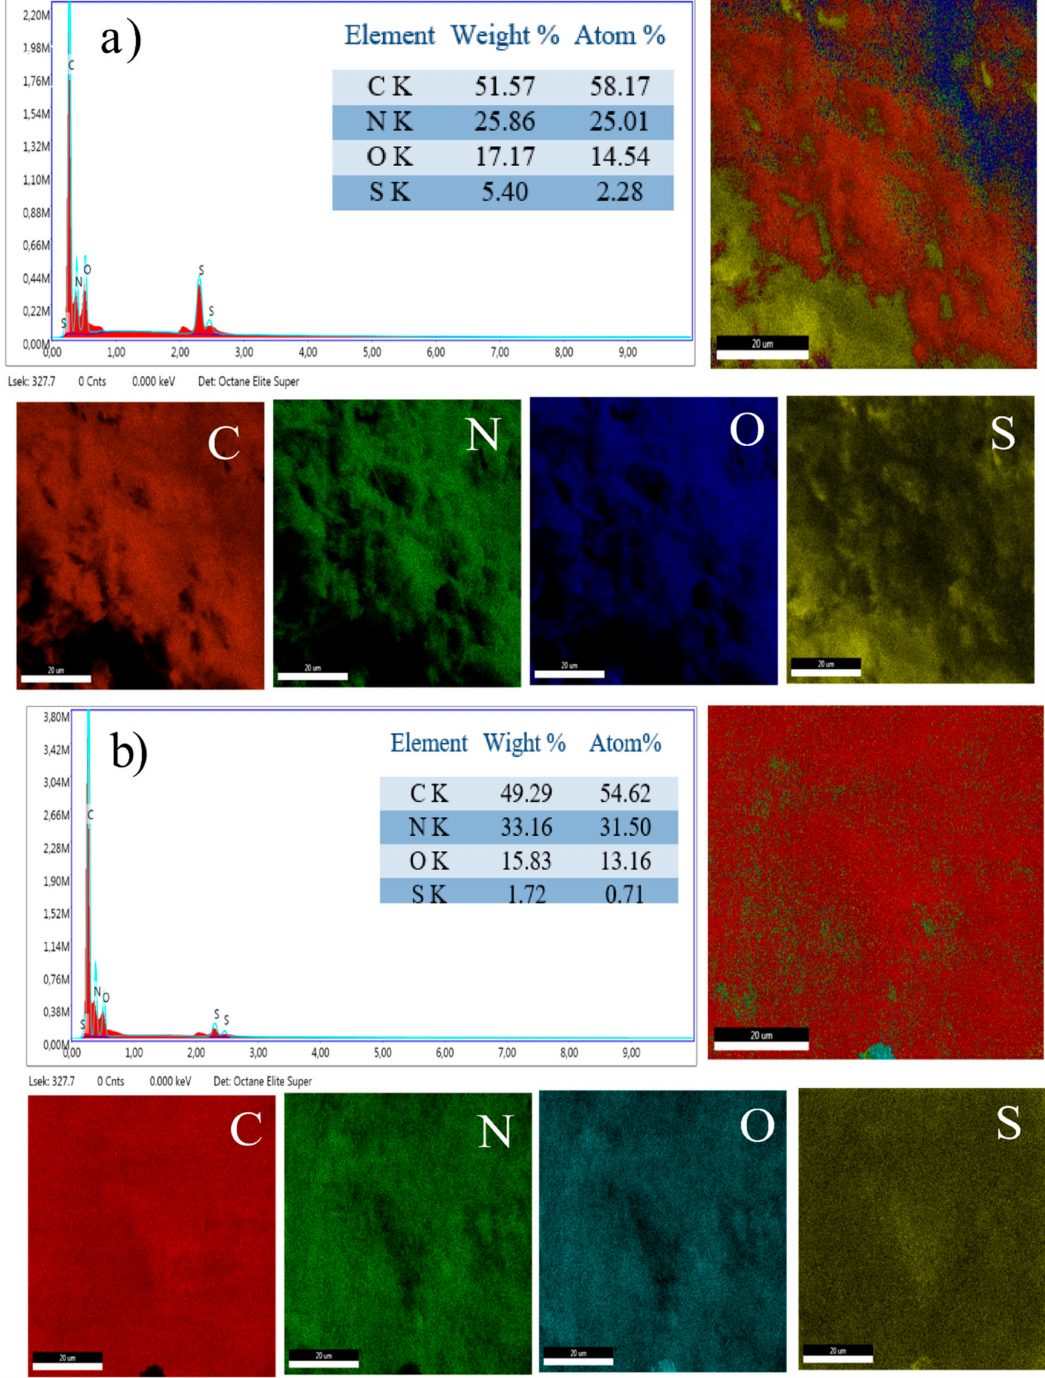
Figure 5. Elemental analysis and mapping of ( a ) ds@PANI / GO and ( b ) cs@PANI /